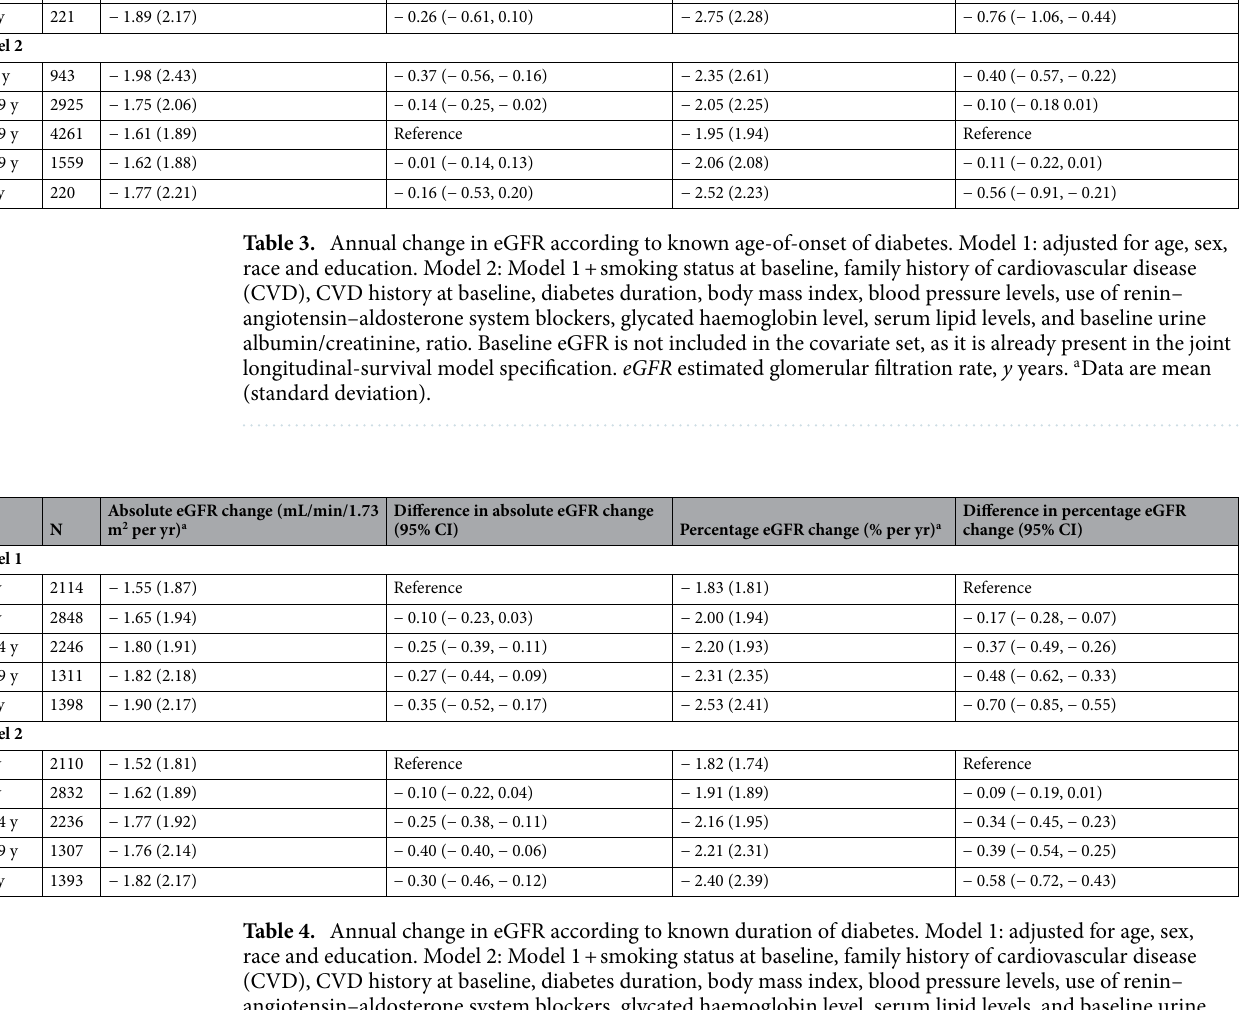
Table 4. Annual change in eGFR according to known duration of diabetes. Model 1: adjusted for age, sex, race and education. Model 2: Model 1 + smoking status at baseline, family history of cardiovascular disease (CVD), CVD history at baseline, diabetes duration, body mass index, blood pressure levels, use of renin– angiotensin–aldosterone system blockers, glycated haemoglobin level, serum lipid levels, and baseline urine albumin/creatinine, ratio. Baseline eGFR is not included in the covariate set, as it is already present in the joint longitudinal-survival model specification. eGFR estimated glomerular filtration rate, y years. a Data are mean (standard deviation).